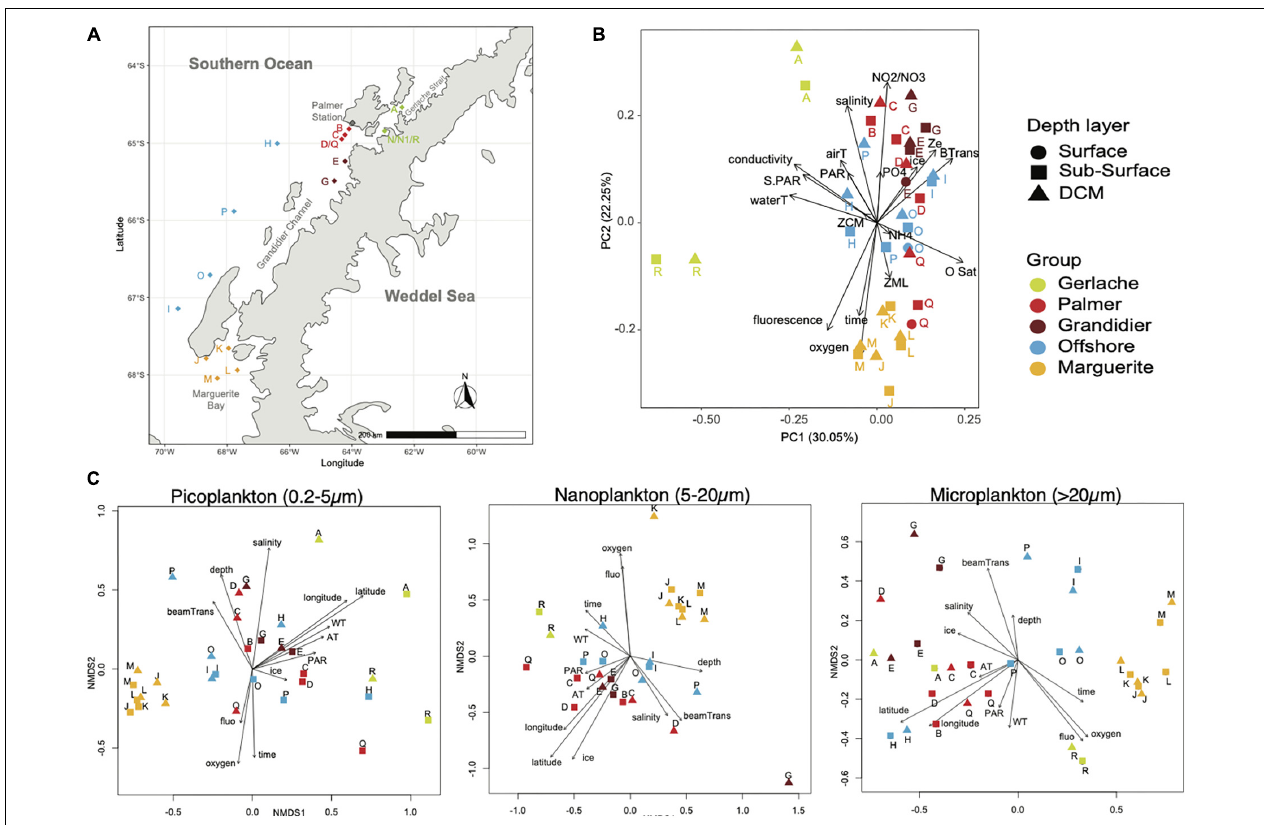
FIGURE 1 | Sample distribution: (A) A chart of stations sampled during the NBP19-10 cruise. (B) Principal component analysis of environmental parameters showing five groups of samples related to geographical location. (C) Non-metric multidimensional scaling analysis of micro-, nano-, and pico-plankton, showing a similar pattern as the environmental parameter